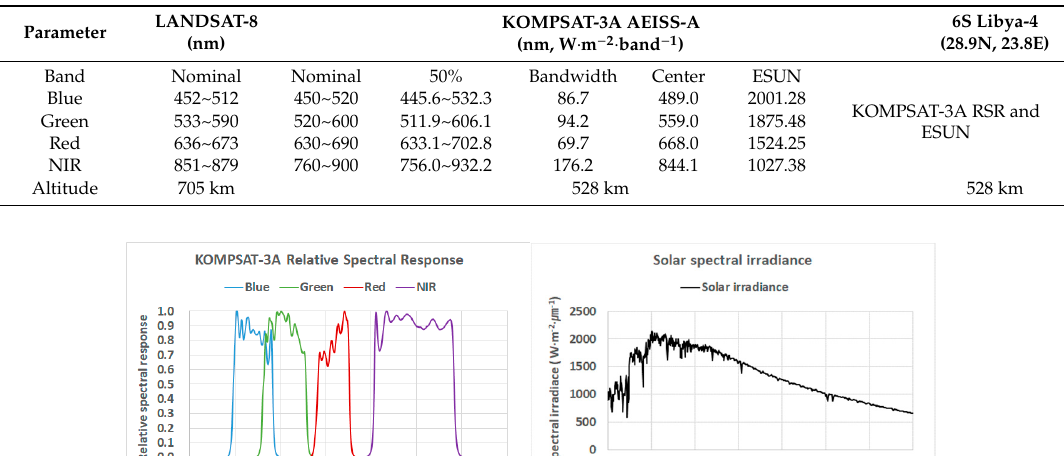
Table 2. KOMPSAT-3A characteristics and the Second Simulation of Satellite Signal in the Solar Spectrum (6S).